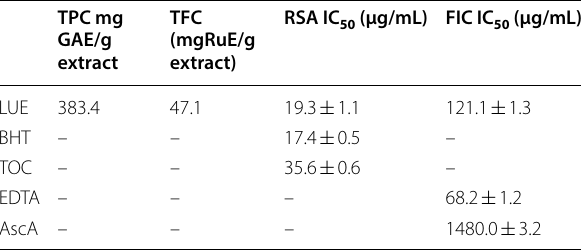
Values are presented as means